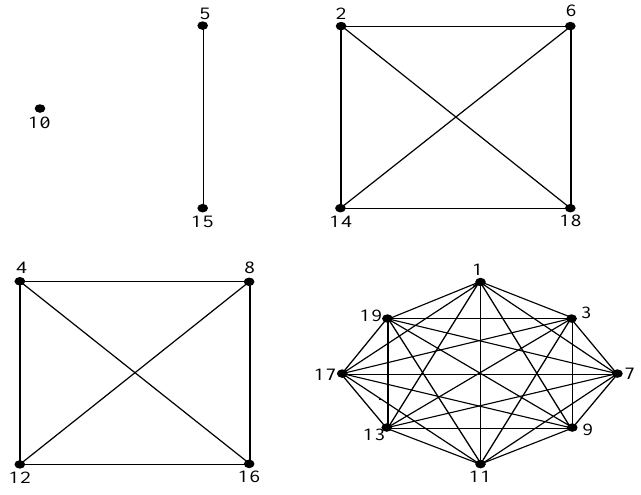
Figure 1. The associate ring graph AG ( Z 20 ) .